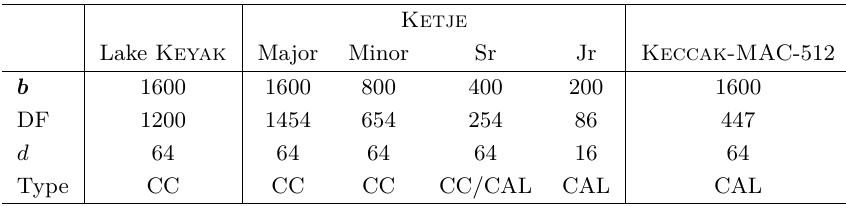
Table 6: Keccak - p -based constructions and their available degrees of freedom and dimensions of cubes used in attacks. ‘Type’ refers to the attack which is more